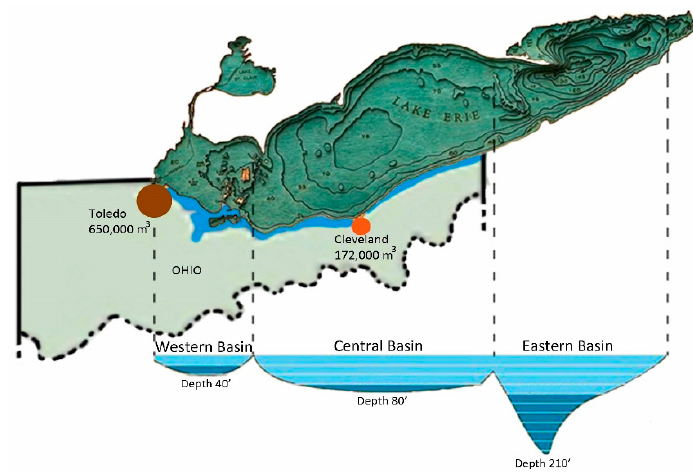
Figure 3. Map of Lake Erie: physical features and areas with immediate action required (Toledo brown large circle and Cleveland red small circle indicate immediate actions required due to huge amounts of sediments dredged in these harbors) (Reference [5]).